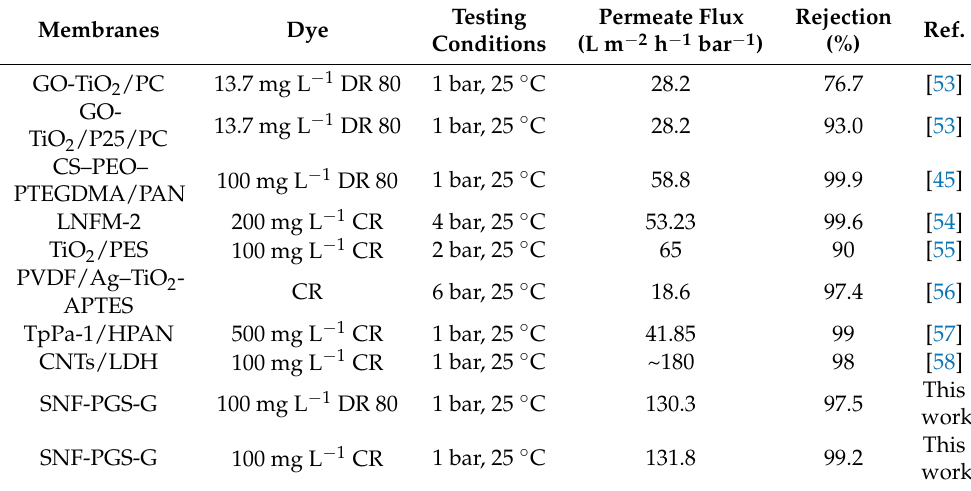
Table 3. Performance comparison between the membranes in this work and the reported